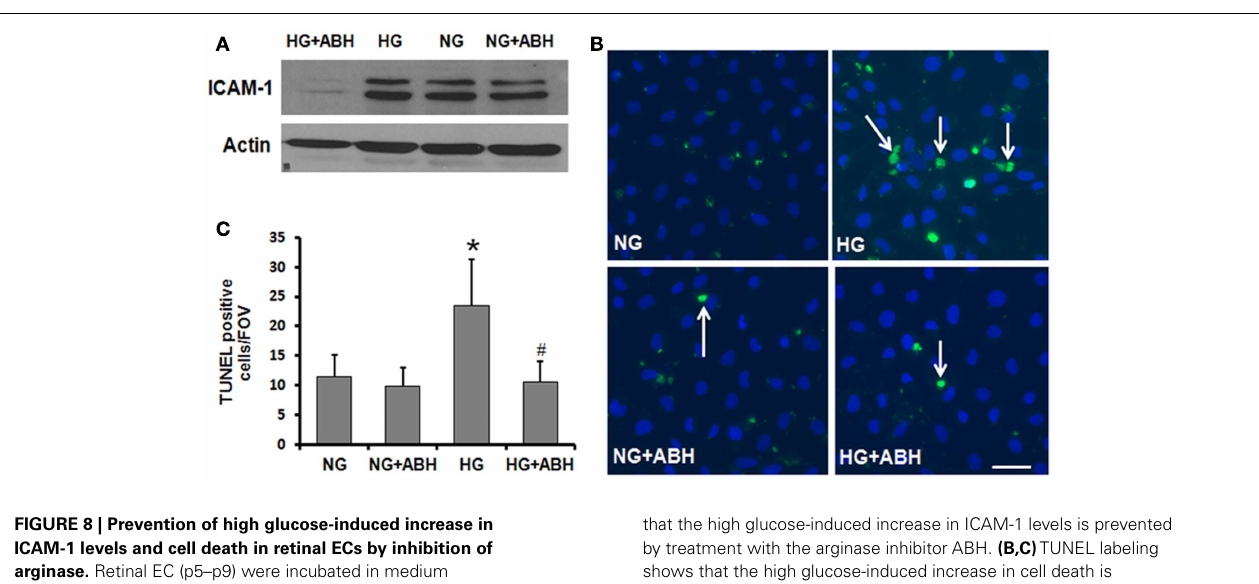
FIGURE 8 | Prevention of high glucose-induced increase in ICAM-1 levels and cell death in retinal ECs by inhibition of arginase. Retinal EC (p5–p9) were incubated in medium (M199 + 0.2%FBS + 50 µ M l-arginine) containing 5.5mM d-glucose (NG) or 25mM d-glucose (HG) for 3days. (A) Western blotting shows